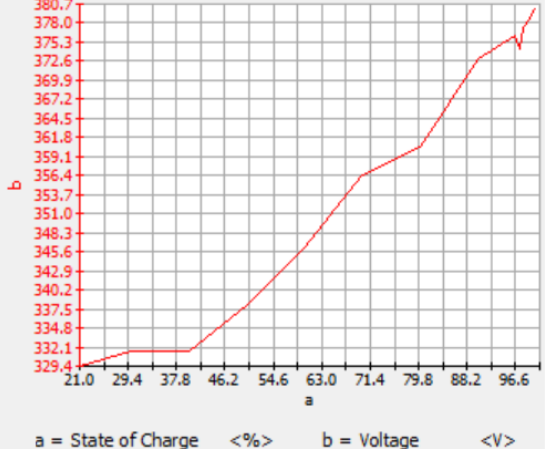
Figure 6. Relationship between battery SOC and battery output voltage.